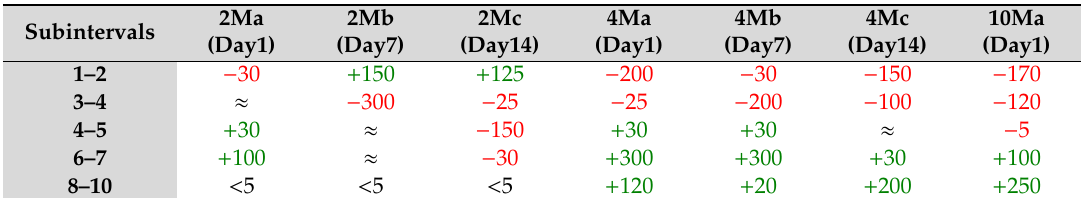
Table 2. Changes in nuclei size distribution compared with control groups (%). Subintervals denote the subgroups of cells with di ff erent sized nuclei as described in Figure 3. The values represent the percent change of irradiated nuclei size relative to control (%). Red represents a decrease and green represents an increase.